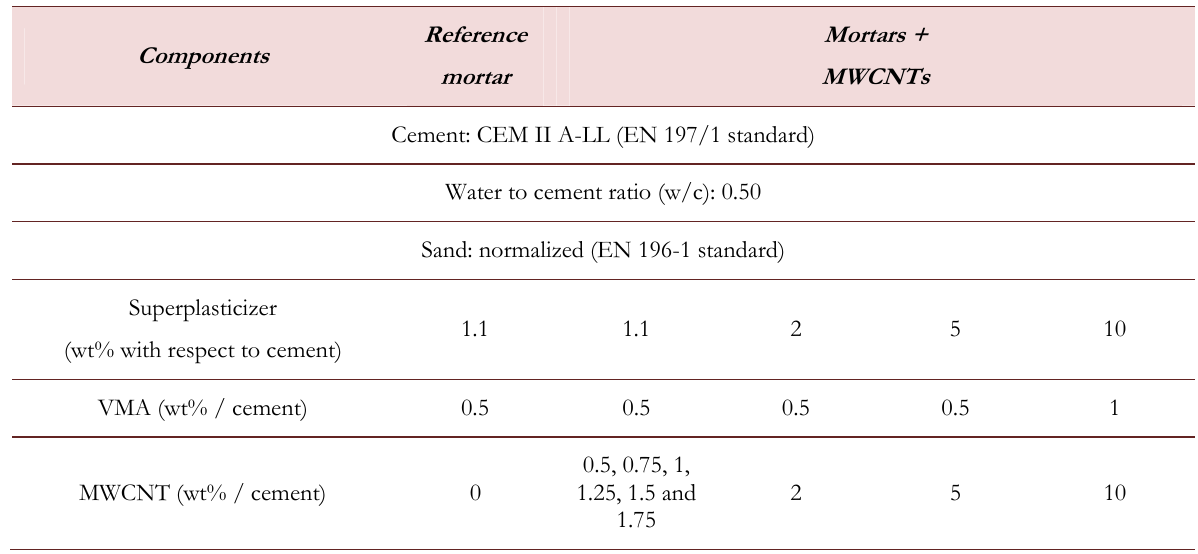
Table 2: Mix-design of the prepared